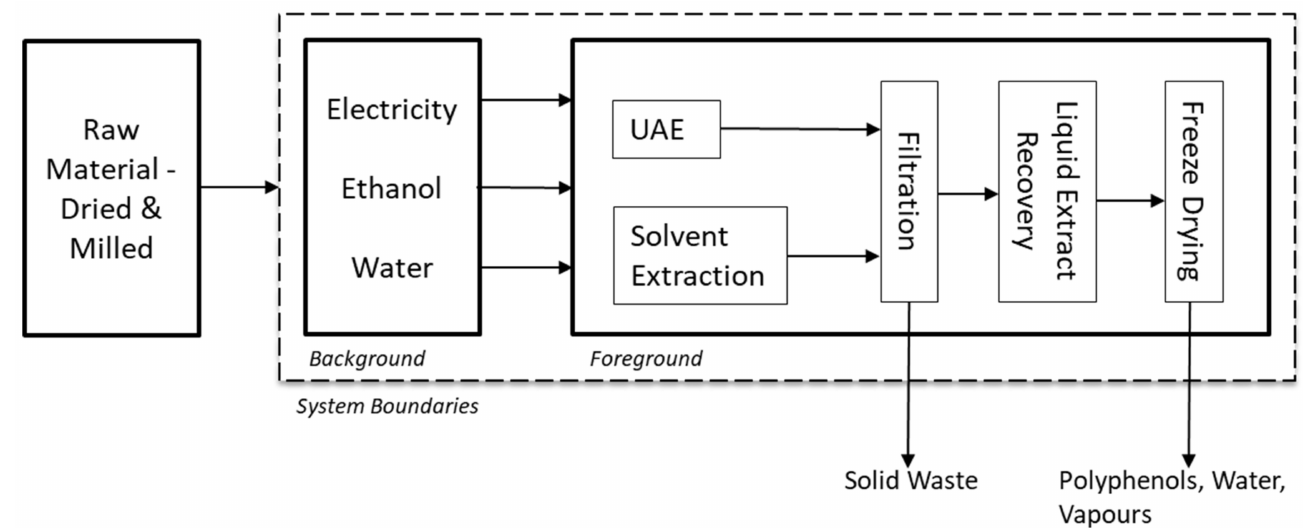
Figure 2. Schematic representation of the studied system boundary (dashed line).